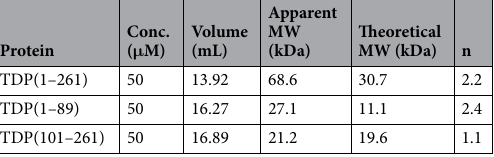
Table 1. Apparent MWs of the N-terminal fragments of TDP-43 as determined by SEC. The Superdex-200 Increase 10/30 GL column was applied to SEC experiments. n, ratio of the apparent MW to theoretical MW; Conc.,